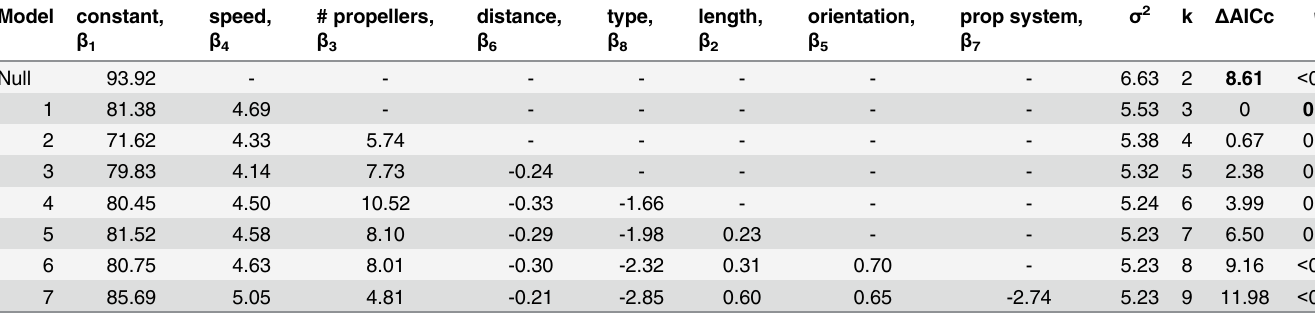
Table 3. Negative log likelihood model results, excluding research vessel-only intervals. Model constant, β 1